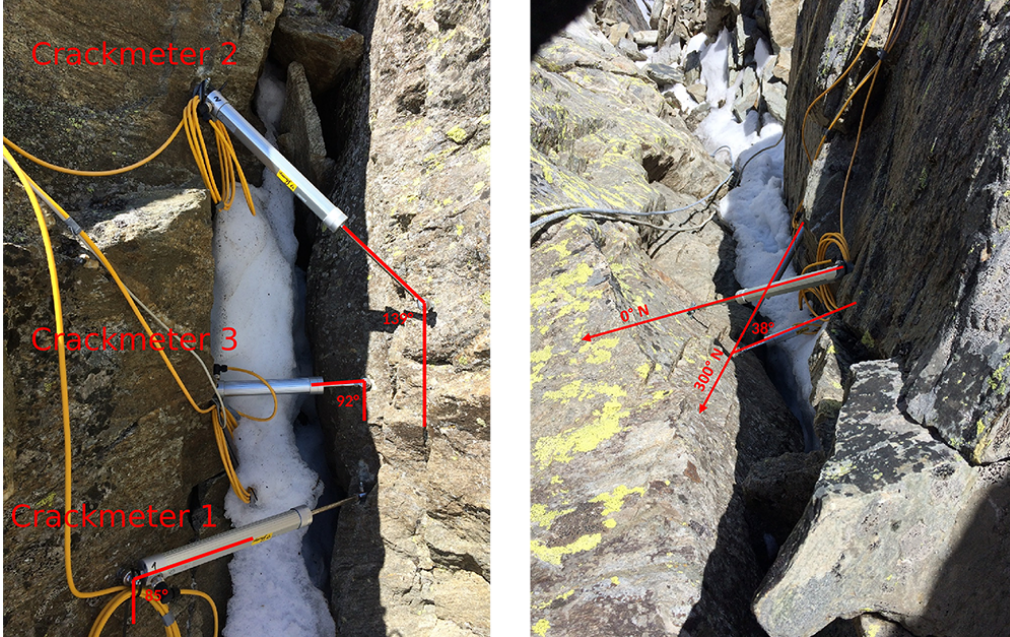
Figure C6. Sensor setup at position MH09 with three crackmeters and one surface thermistor channel.